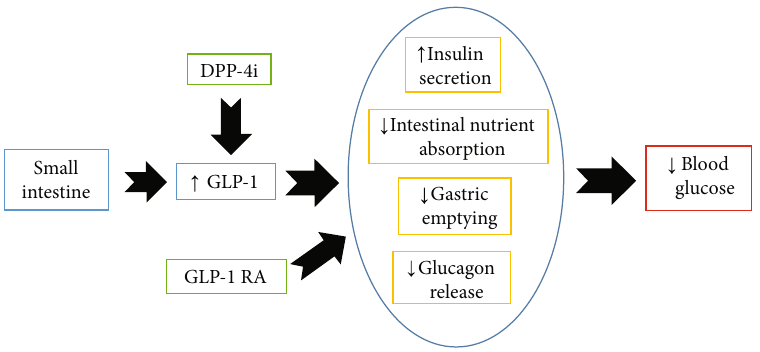
Figure 1: Schematic mechanism of action of incretin-based medications. Table 1: Approved forms of incretin-based